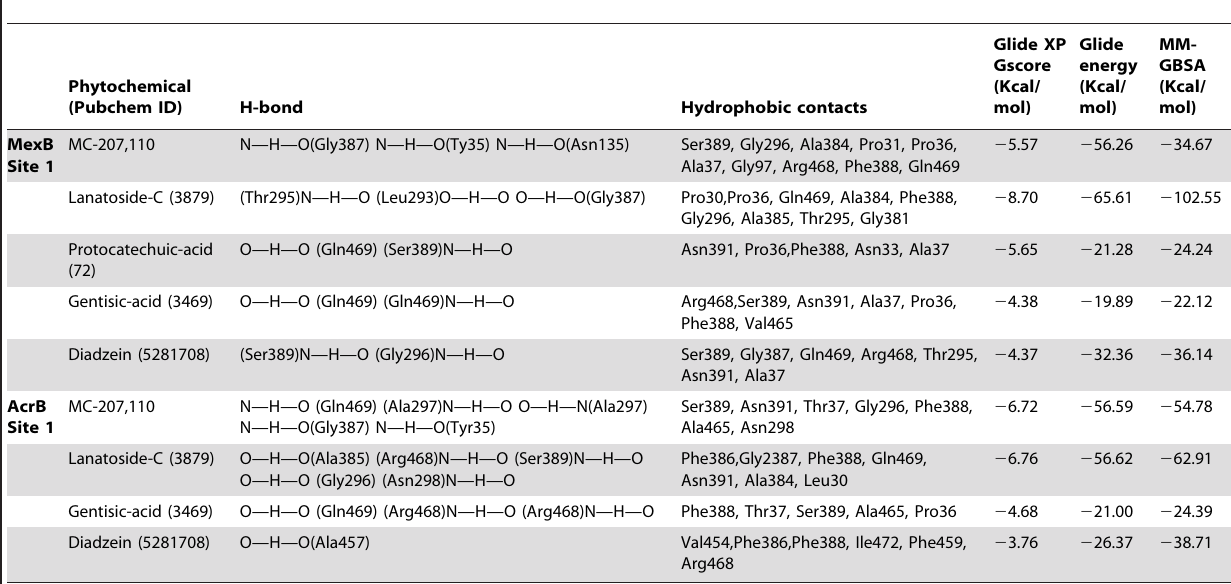
Table 1. Molecular interactions of phytochemicals with the active site residues in the binding site 1 of the target proteins, MexB of P. aeruginosa and AcrB of E. coli